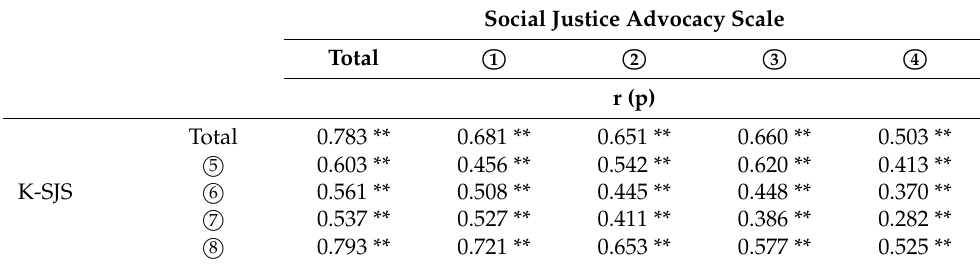
Table 4. Correlation between K-SJS and Social Justice Advocacy Scale ( N =